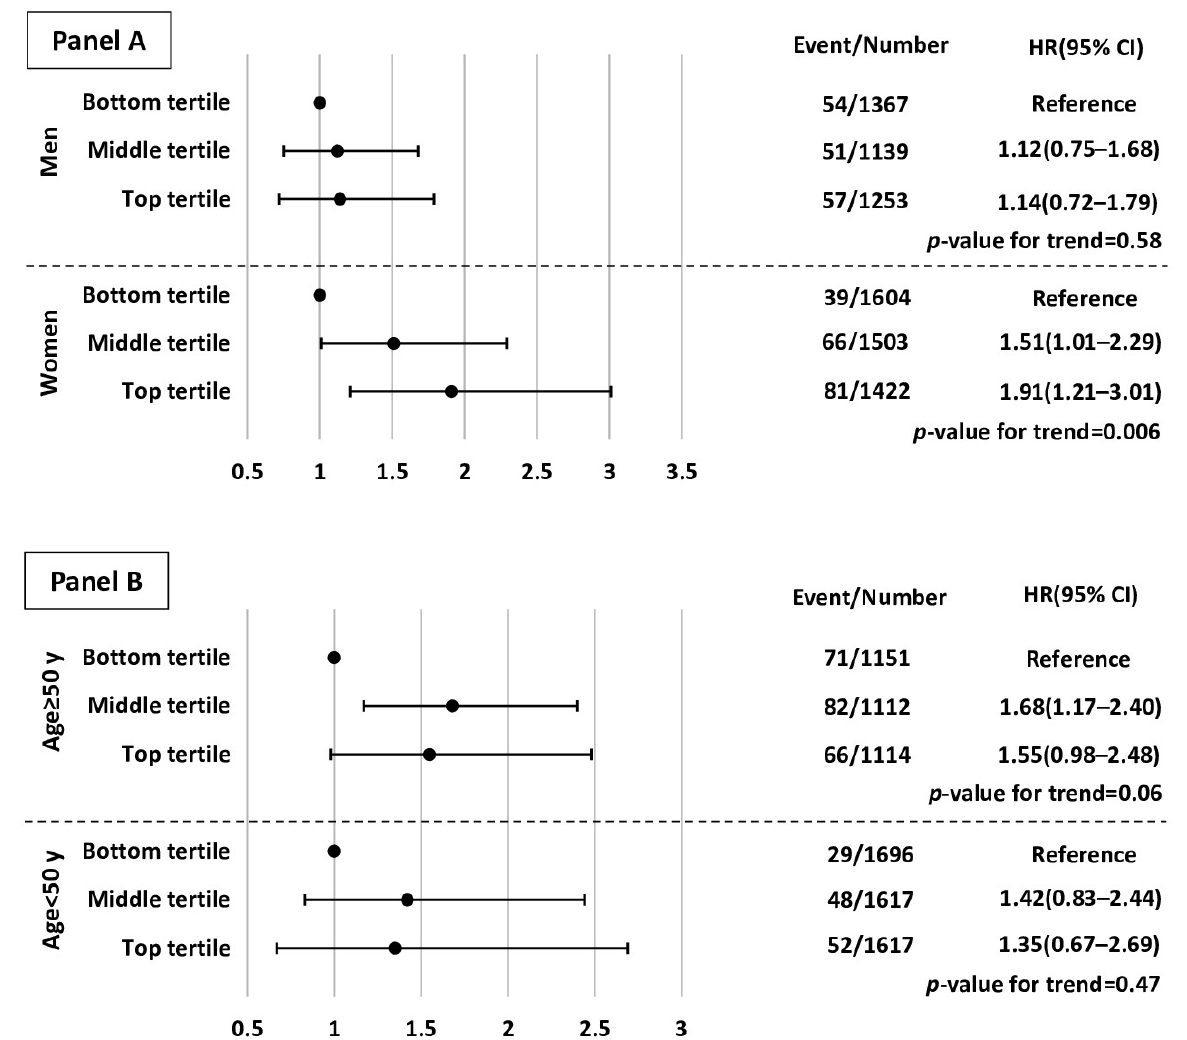
Figure 2. Multivariate hazard ratios (HRs) and 95% confidence intervals (CI) of incident any fractures for wrist circumference stratified based on sex and age: Tehran Lipid and Glucose Study, 1999–2016. y: years. Multivariate hazard ratios were adjusted for sex only in panel ( B ), age only in panel ( A ), body mass index, waist circumference, diabetes, hypertension, current smoking, education level, low phys- ical activity, positive history of cardiovascular disease, and use of steroidal medications. p -value for trend (wrist circumference tertiles as a continuous variable in the model). Wrist circumference tertiles measurements in men: [bottom: ≤ 17.4 cm; middle:17.5–18.1 cm; top: ≥ 18.2 cm]; in women: [bottom: ≤ 15.7 cm; middle:15.8–16.5 cm; top: ≥ 16.6 cm]; in age <50 y: [bottom: ≤ 16 cm; middle: 16.1–17.3 cm; top: ≥ 17.4 cm]; in age ≥ 50 y: [bottom: ≤ 16.6 cm; middle:16.7–17.8 cm; top: ≥ 17.9